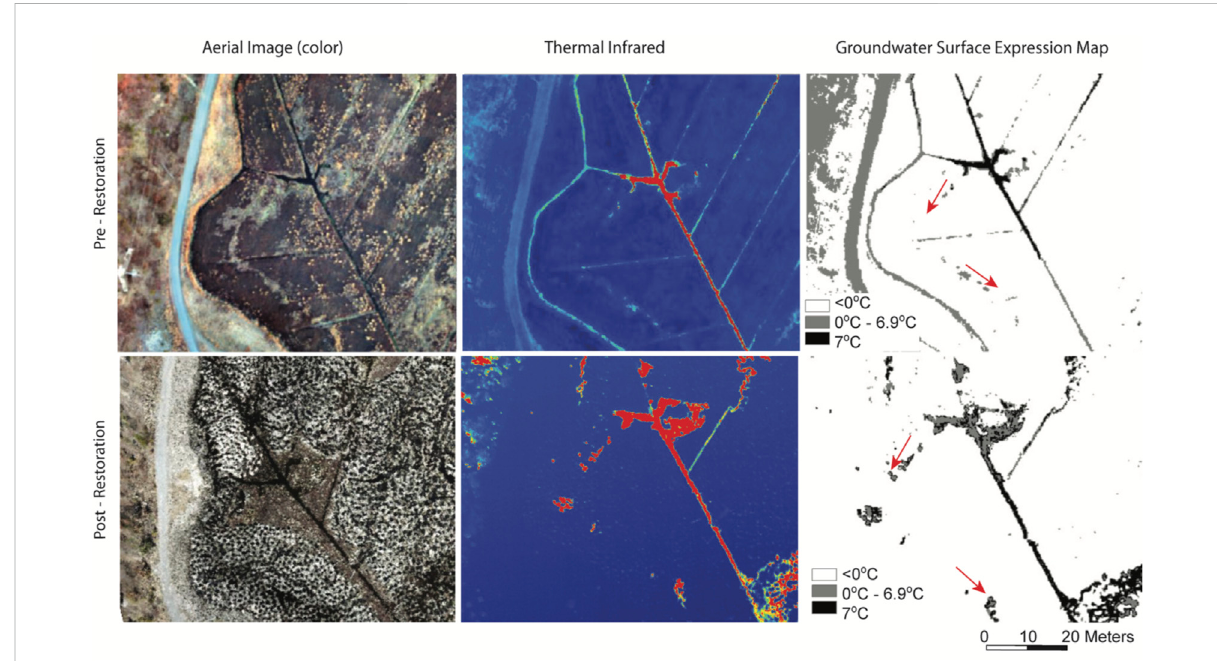
FIGURE 5 Comparative UAS imagery from pre-restoration (top row) to post-restoration at Foothills Preserve, from left to right: (left) plain light (RGB image), (center) thermal infrared, and (right) surface expression of groundwater (black = groundwater and gray = mixing zone). This area of a known groundwater seep was not (intentionally) altered during restoration and did not change the surface area. Red arrows indicate the hypothesized original stream channel fl ow direction (also shown in Figure